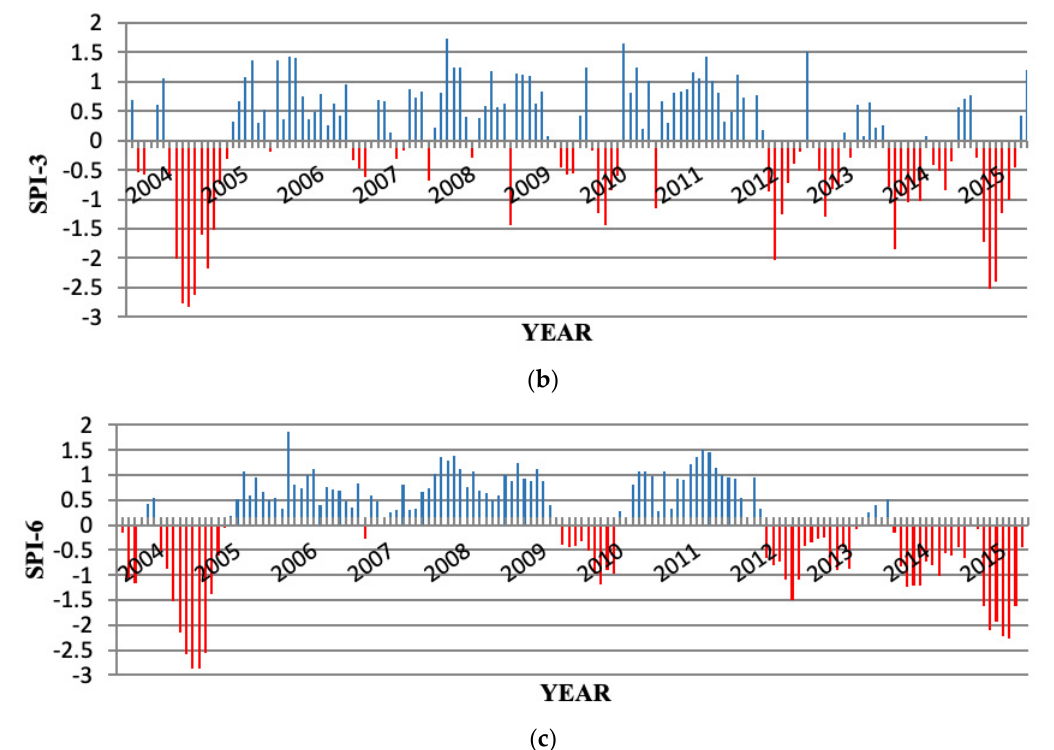
Figure 3. Standardized precipitation index (SPI): ( a ) 1 month, ( b ) 3 months and ( c ) 6 months scale.